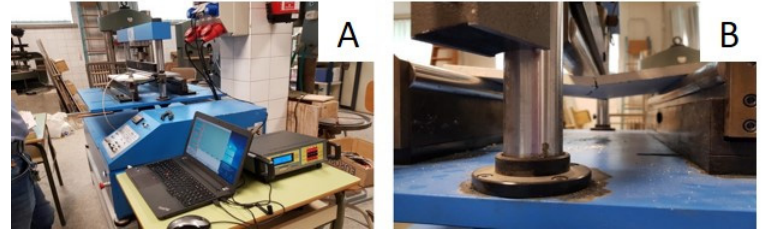
Figure 4. Flexural strength test: ( A ) test equipment; and ( B ) board with PR during test.